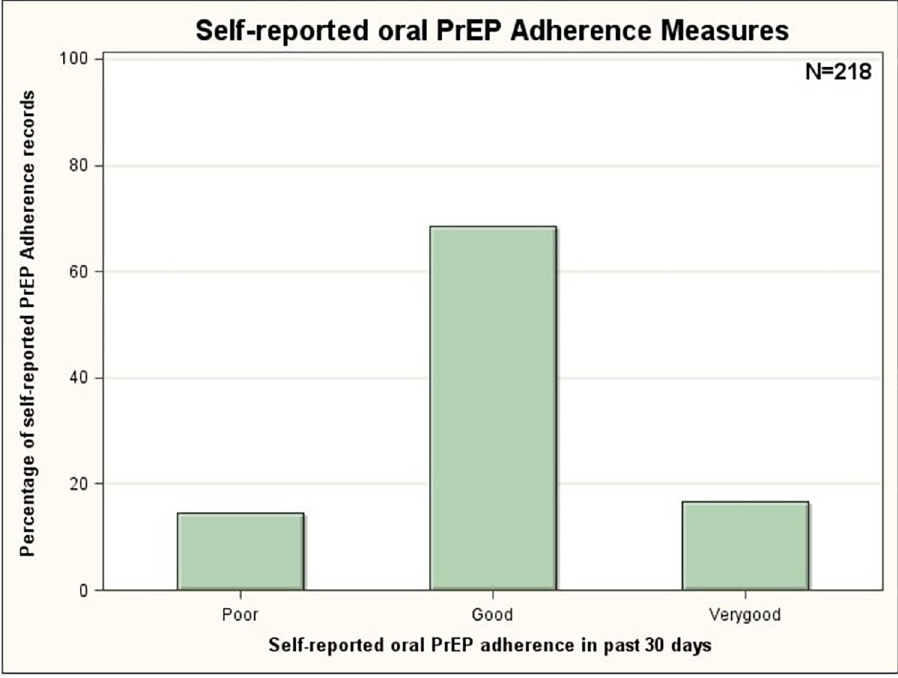
Fig 4. Summary of self-reported PrEP adherence measures in past 30